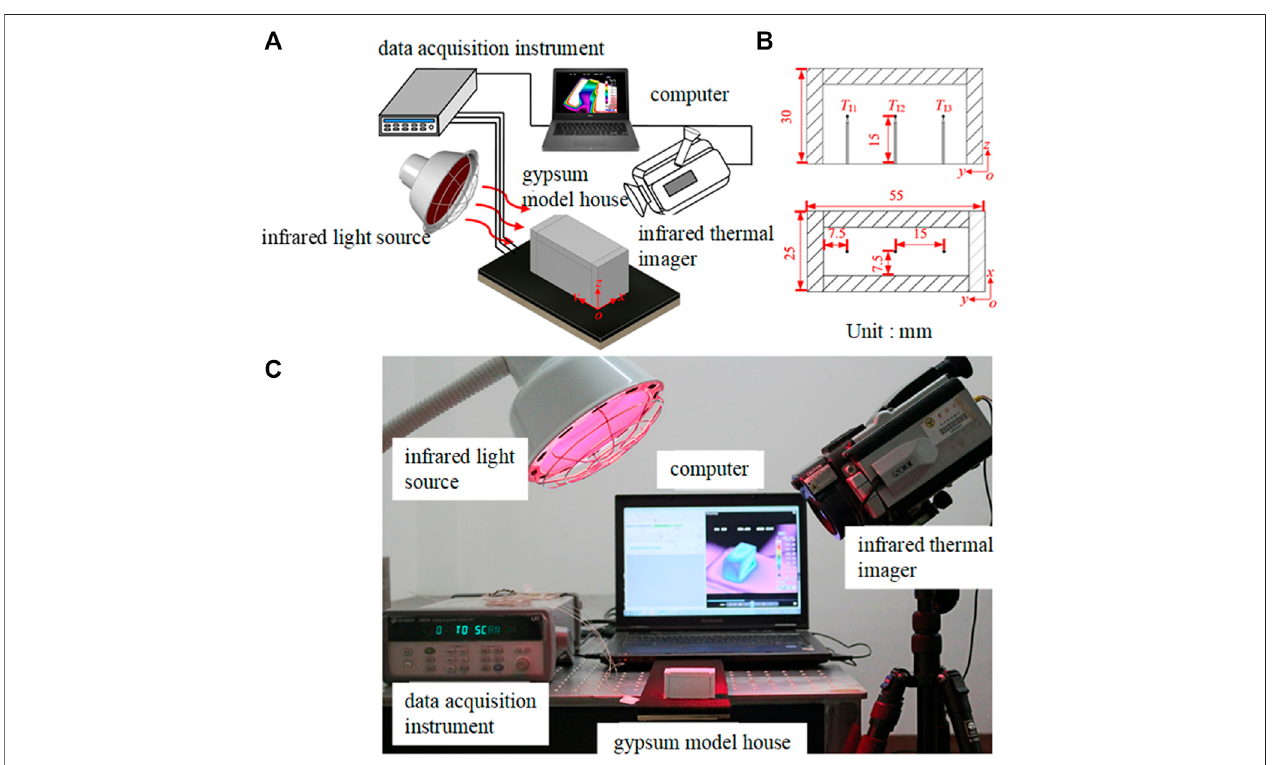
FIGURE 2 | Thermal regulation characterization experiment of PCM capsules: (A) schematic diagram; (B) structure of the model house; (C) photograph of the experimental system.